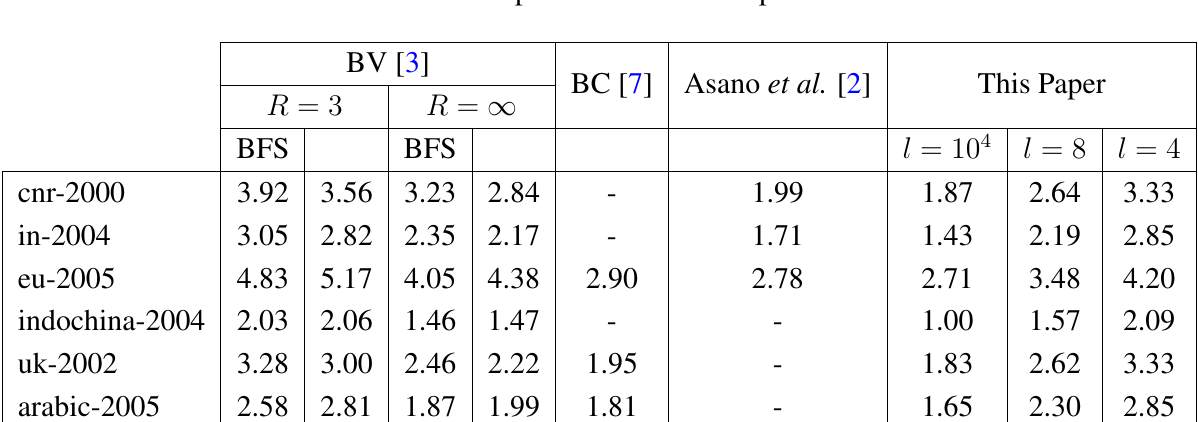
Table 8. Compressed sizes in bits per